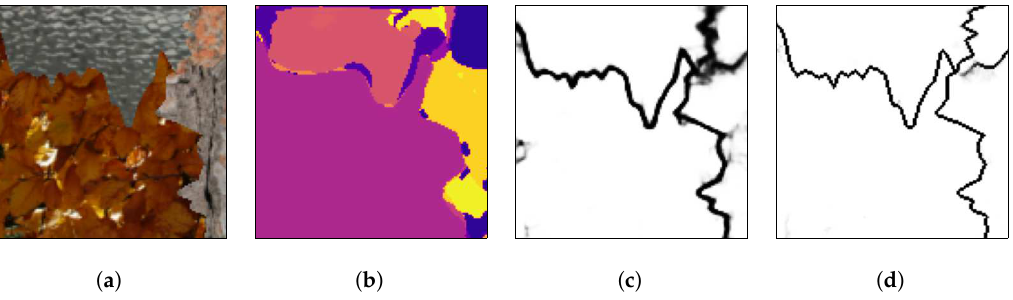
Figure 7. ( a ) An example mosaic, ( b ) the results of a multi-class labeling approach, ( c ) a HED architecture, and ( d ) the proposed